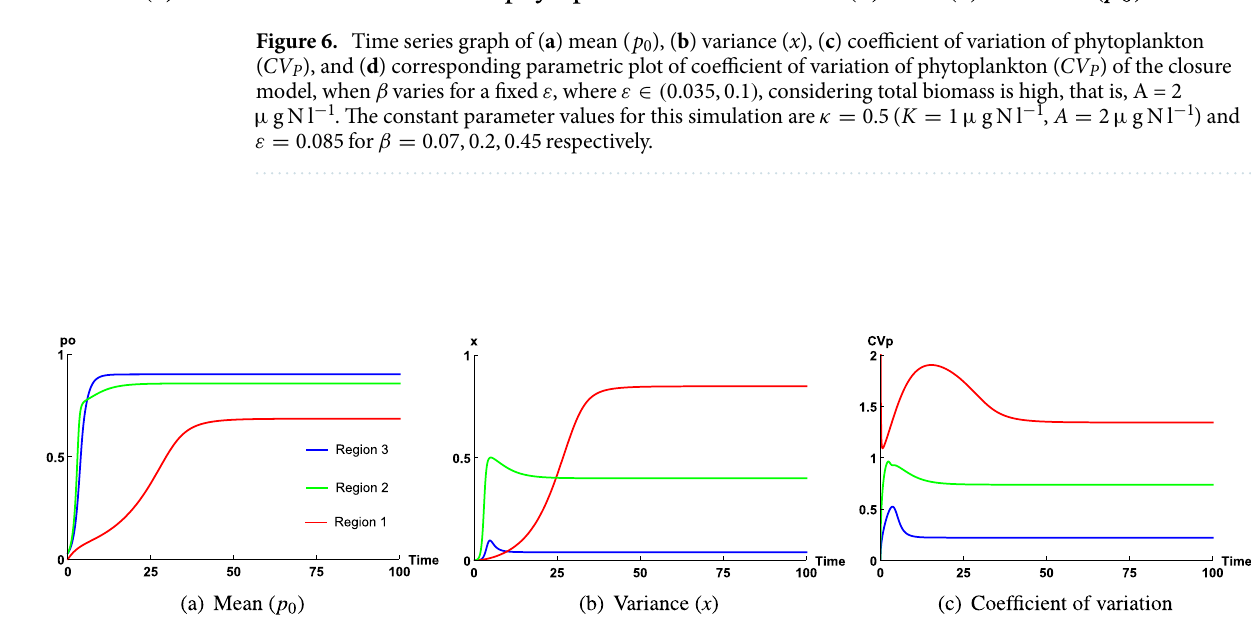
Figure 7. Time series graph of ( a ) mean ( p 0 ), ( b ) variance ( x ), ( c ) coefficient of variation of phytoplankton ( CV P ) of the closure model at Region 2, Region 3 and Region 1 in May 2011. The constant parameter values for 0.6 µ gN l − 1 , A 2 µ gN l − 1 ) for Region 1 and κ 1 µ gN l − 1 , 0.3 ( K 0.5 ( K this simulation are κ = = = = = A 2 µ gN l − 1 ) for Region 2, Region 3 and β 0.93, 0.037, 0.075 corresponding to 1.6, 0.04, 0.4 for ε = = = Region 1, Region 3 and Region 2